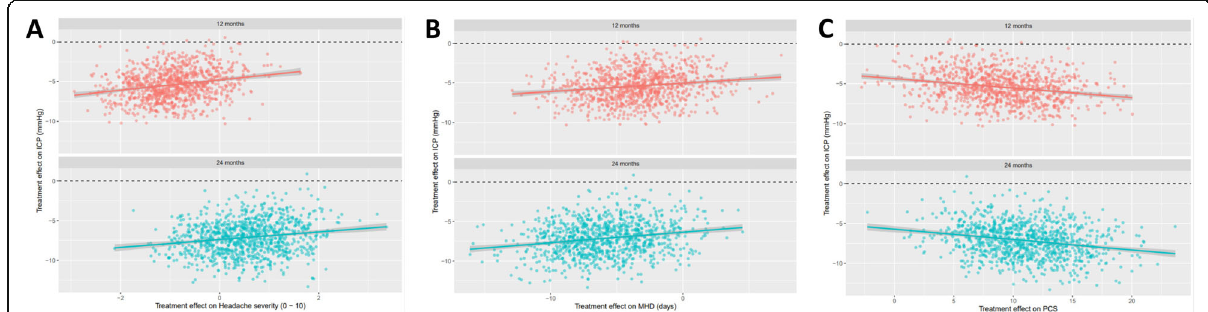
Fig. 2 Bootstrap surrogacy analysis of ICP and headache outcomes. The x-axis reflects change in headache outcomes with change in ICP on the y-axis. The lines are simple linear regressions and the shaded regions are 95% confidence intervals of the mean. Changes in intracranial pressure are plotted at 12 and 24 months. Each positive value represent improvement i.e. reduction in ICP and headaches outcomes, with the larger the angle of the slope the greater the relationship. A Illustrates headache severity on the y axis with a positive association with ICP over the time horizons. B Illustrates monthly headache days (MHD) on the y axis with a positive association with ICP over the time horizons. C Illustrates quality of life physical component score (PCS) on the y axis with a positive association with ICP over the time horizons